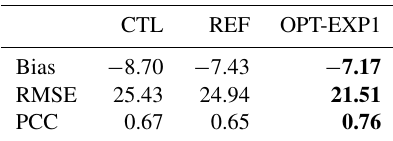
Table 5. Continuous statistics for CTL, REF, and OPT-EXP1. The best results are presented in